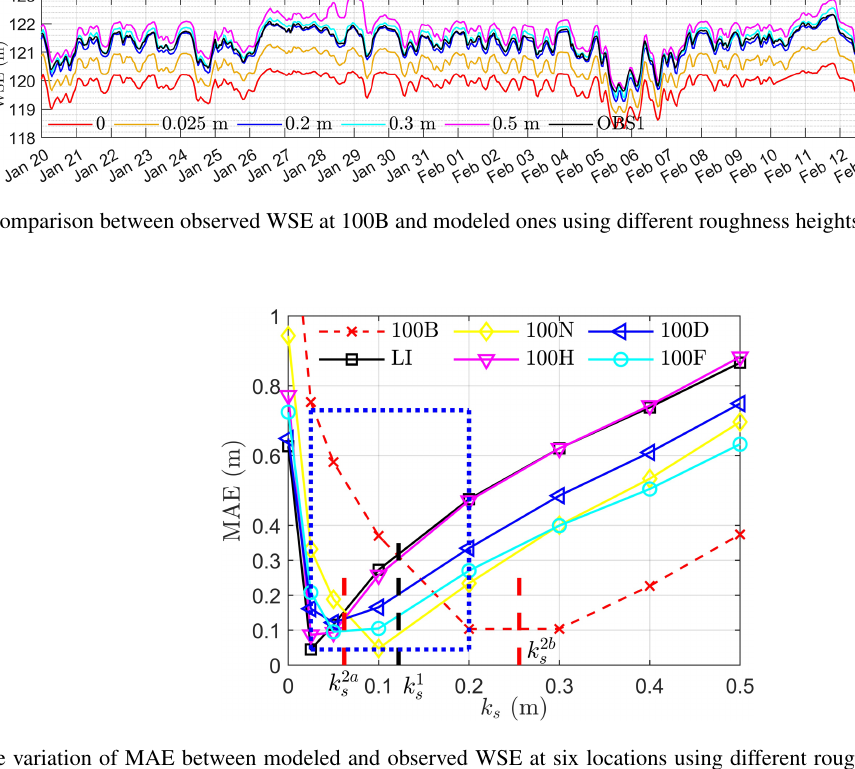
Figure A3. The variation of MAE between modeled and observed WSE at six locations using different roughness parameters. Black and red vertical lines represent the optimal roughness height using one- k s and two- k s strategies. Here, the one- k s and two- k s strategies represent using a single uniform or two uniform roughness heights for the streambed,